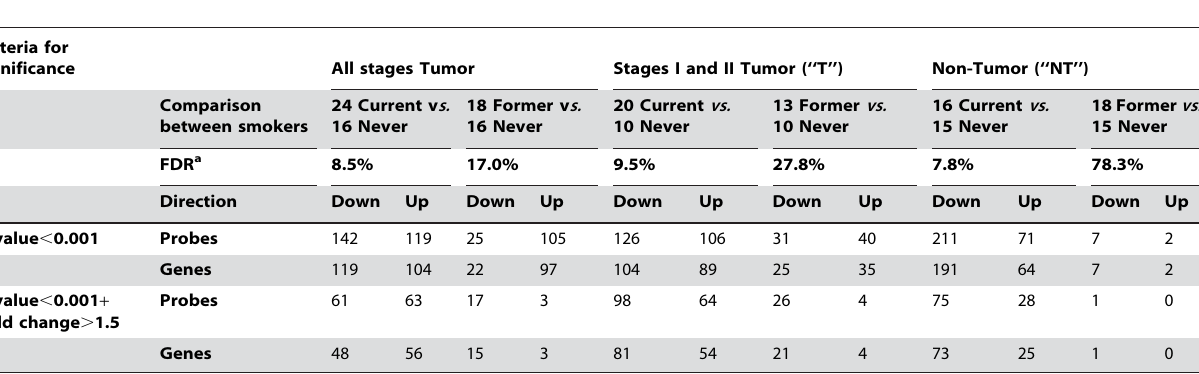
Table 1. Number of probes and genes differentiating current from never smokers (C/N) and former from never smokers (F/N) in all tumor samples, early stage tumor samples (T), and all non-tumor (NT) tissue samples.